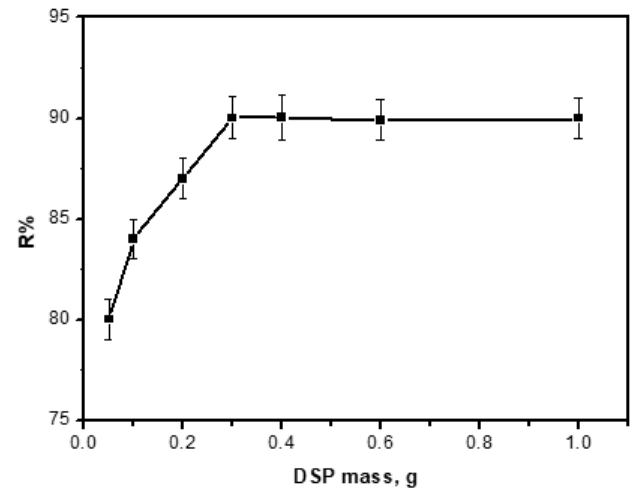
Figure 5. Effect of the DSP mass on the removal efficiency of Ni(II) ions. Figure 5. E ff ect of the DSP mass on the removal e ffi ciency of Ni(II) ions.